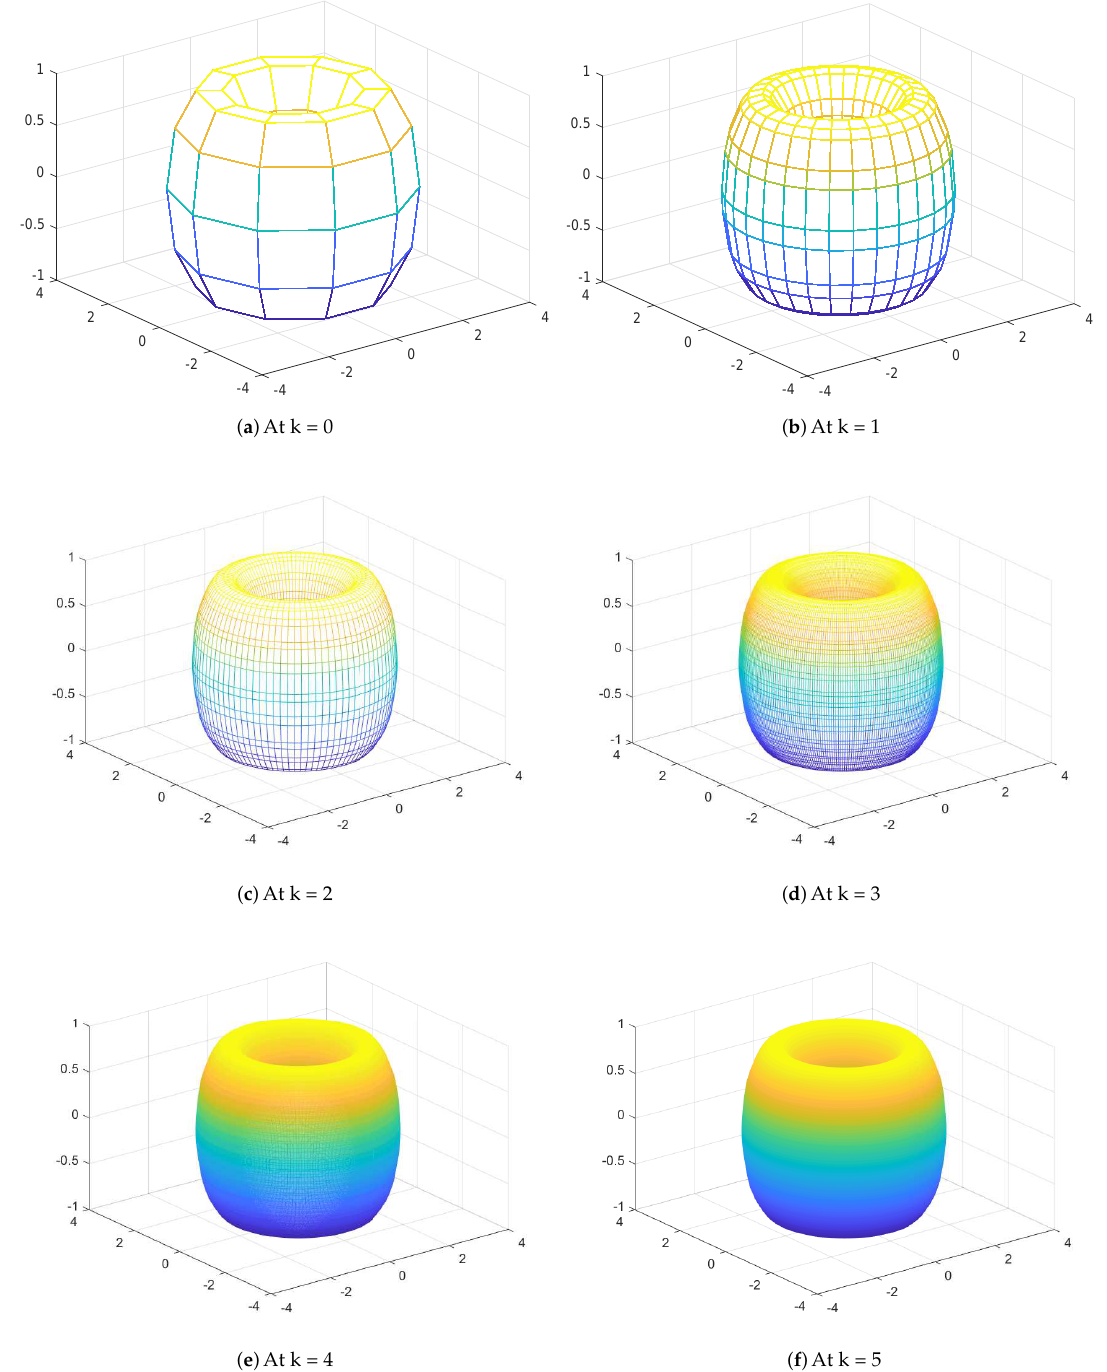
Figure 1. ( a ) The initial polygon; and ( b – f ) the results up to fifth subdivision